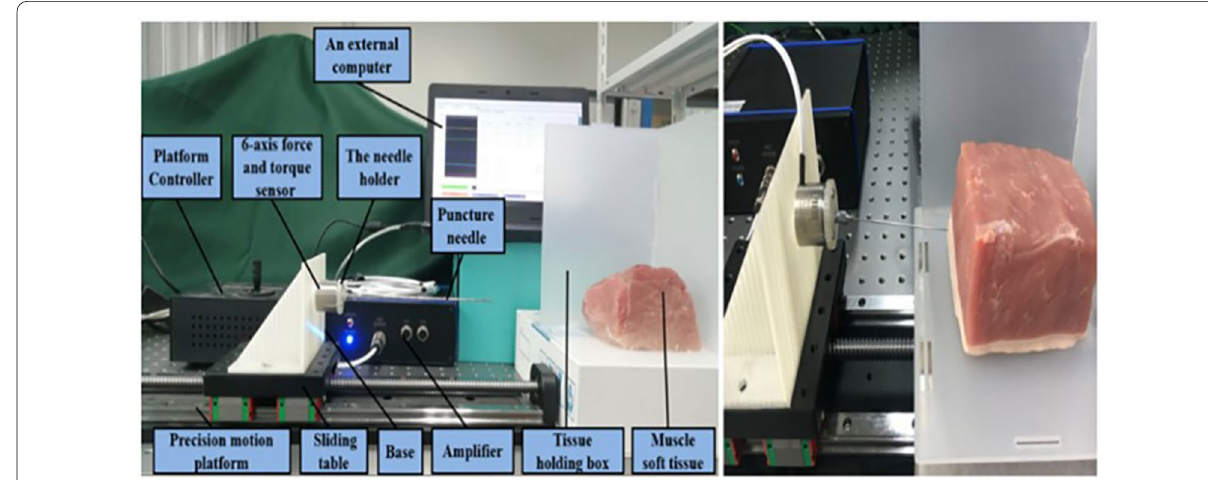
Figure 10 The device of experiment